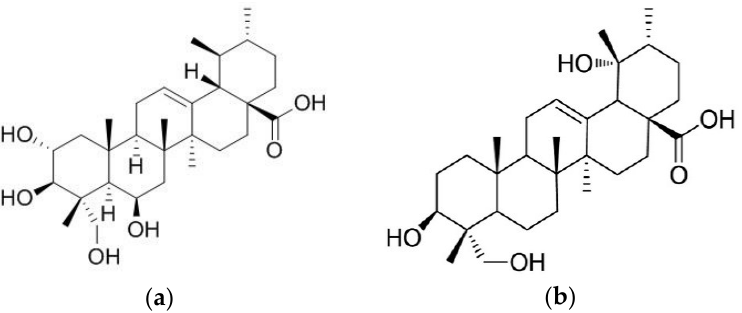
Figure 1. Structure of madecassic acid and rotundic acid. ( a ) Madecassic Acid; ( b ) Rotundic Acid.